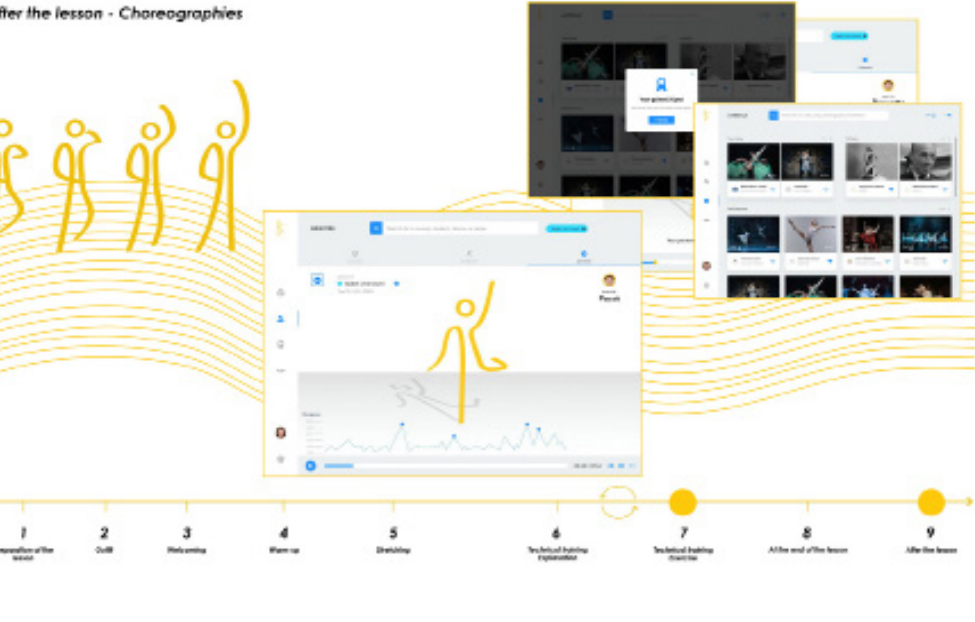
Fig. 17 Zambonini A., mock-up of the graphic interface of the PASSAY educational game: phase “preparation of the lesson”,